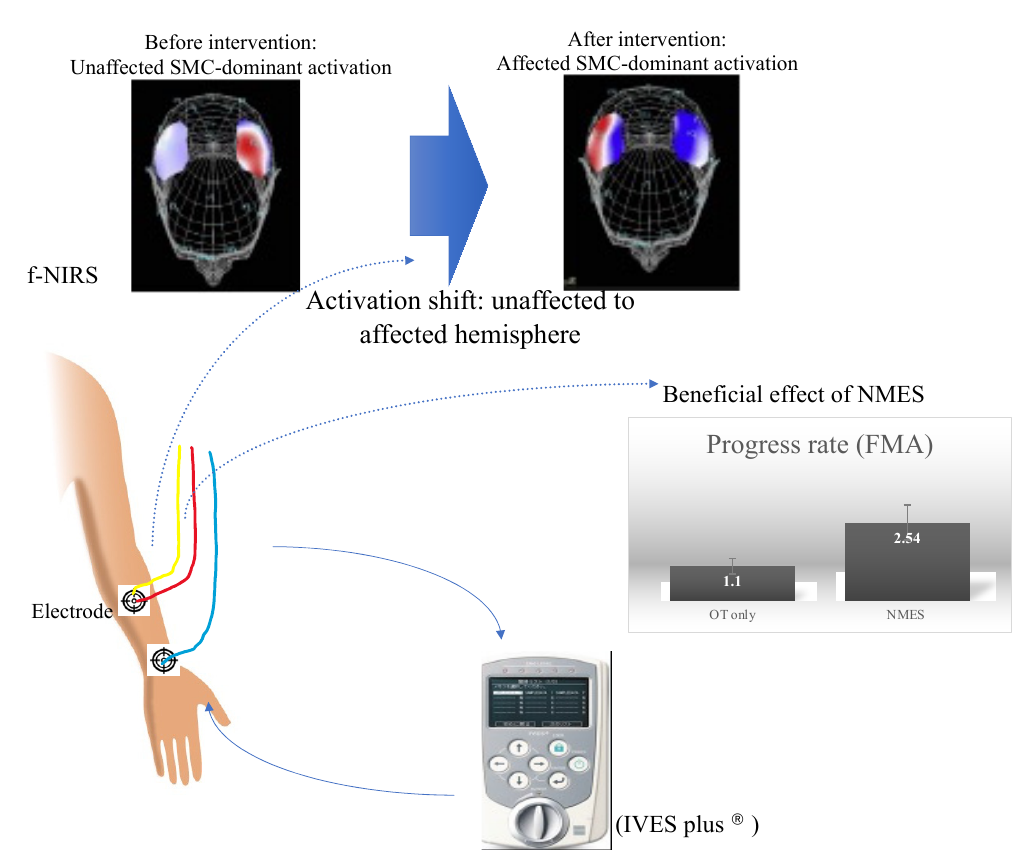
Figure 7. NMES setting (placement of electrodes applied to FDS) and neural basis underlying the beneficial effect of NMES on motor recovery. The scheme illustrates that NMES, when applied to affected forearm muscles, can facilitate motor recovery as shown by augmented PR and subsequently generate cortical reorganization of affected SMC activation, revealed by f-NIRS. FDS: flexor digitorum superficialis; SMC: sensory-motor cortex.